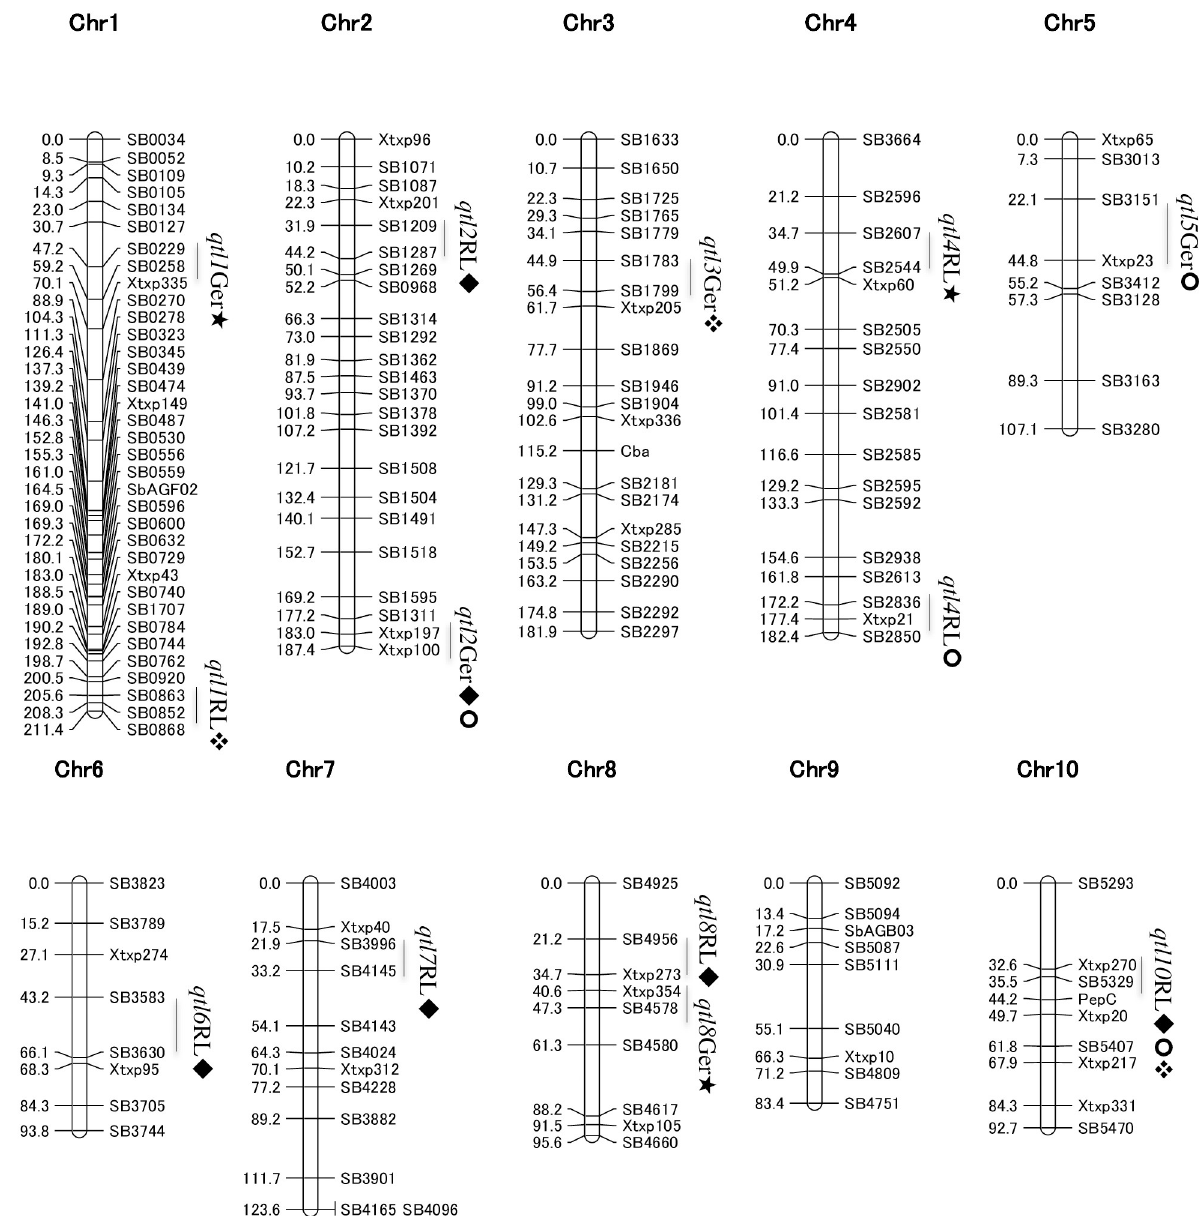
Fig 2. Association analysis of 181 SSR markers and eight traits studied on germination and root length of lattice plants using water soluble extracts from 107 sorghum accessions (SDRS).